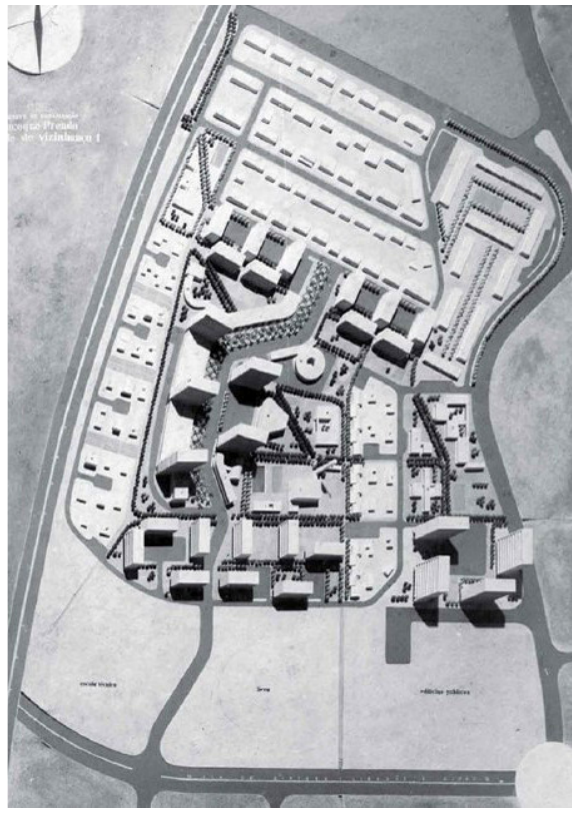
Figure 2. Neighbourhood Unit No. 1, Luanda (model pho‐ tograph, 1961–1963). Source: Courtesy of Fernão Simões de Carvalho.